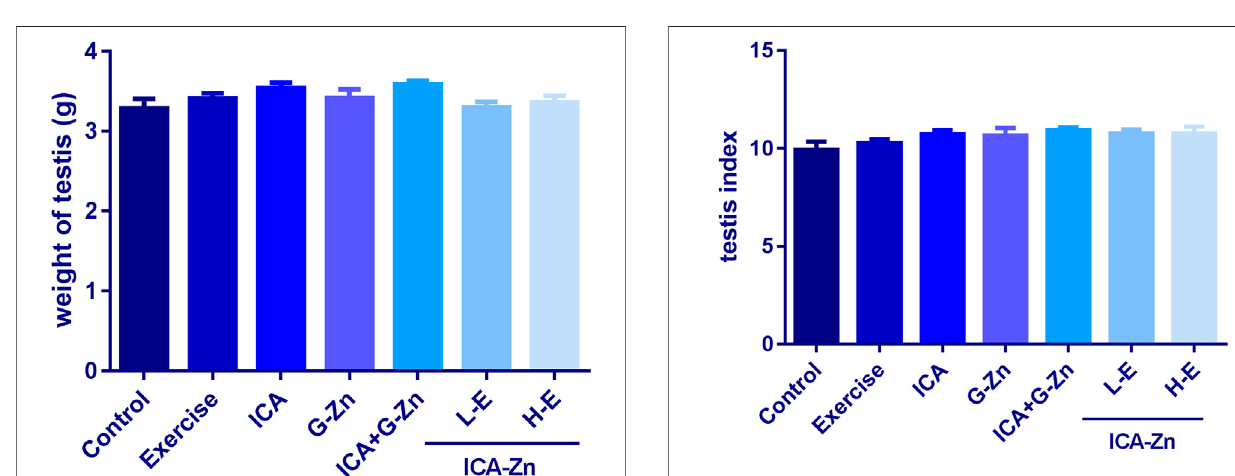
FIGURE 6 | Effect of icariin-zinc on testis weight in rats ( n (cid:2) 8, mean ± SD).